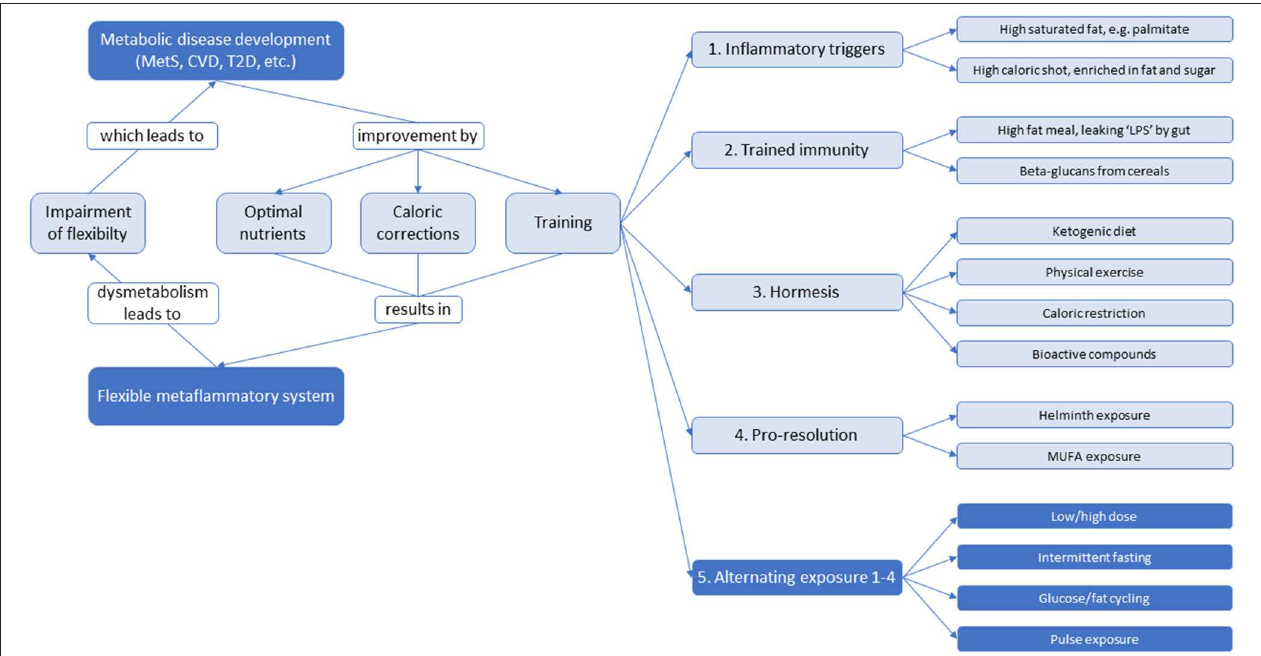
FIGURE 7 | An overview of potential ingredients and strategies for systemic low-grade inflammation therapy to optimize dynamics of inflammation and to maintain a flexible metabolic-inflammatory system. With impairment of flexibility, the system will develop toward metabolic disease development. This can be returned via static nutritional strategies by optimizing nutrients and calories, as well as training strategies through inflammatory triggers, trained immunity, hormesis, pro-resolution, or an alternating combination